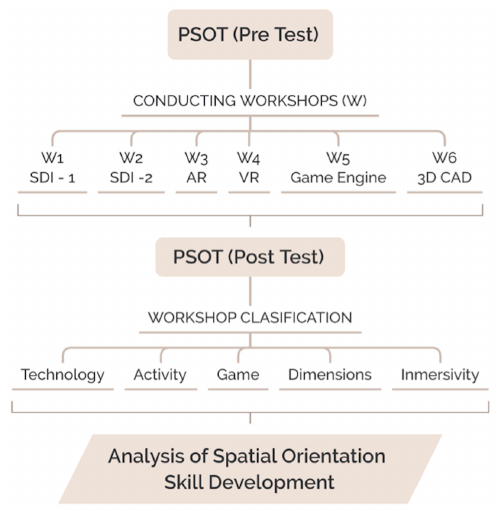
Figure 1. Research process methodological diagram.